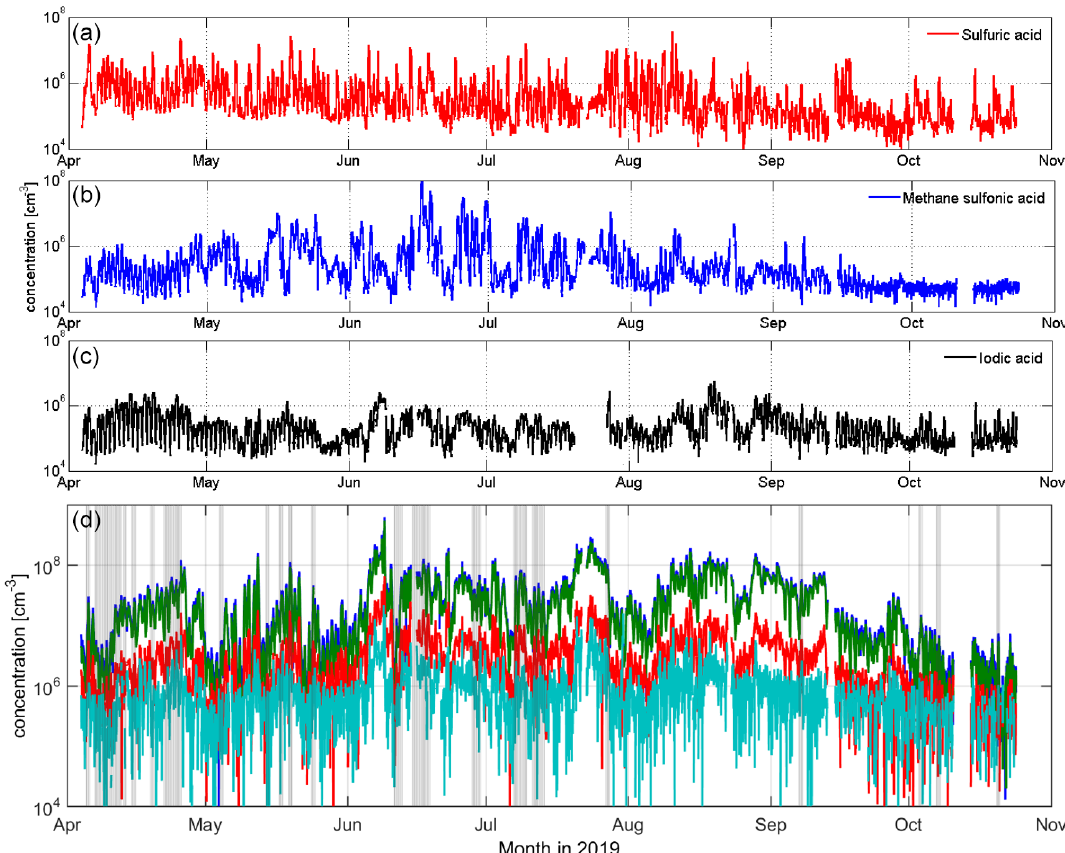
Figure 1. Overview of sulfuric acid (a) , methane sulfonic acid (b) , iodic acid (c) and HOM (d) concentrations at SMEAR I from April to October 2019. NPF days are depicted using gray shading in panel (d) . All of the data in panels (a–c) result from high-resolution peak fitting. HOM data are sums of certain mass ranges: from 300 to 400Th in green, representing C 10 or HOM monomer compounds; from 401 to 500Th in red, representing C 15 compounds; and from 501 to 600Th in light blue, representing C 20 or HOM dimer compounds. The sum of HOM (darker blue) is the sum of the aforementioned mass ranges. The sum of HOMs is approximately 1 order of magnitude higher than the SA, MSA or IA concentrations during this measurement